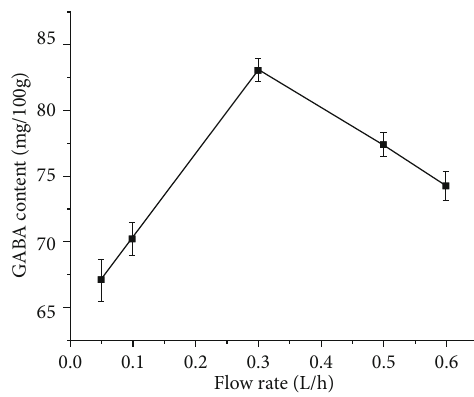
Figure 5: E ff ect of fl ow rate on GABA